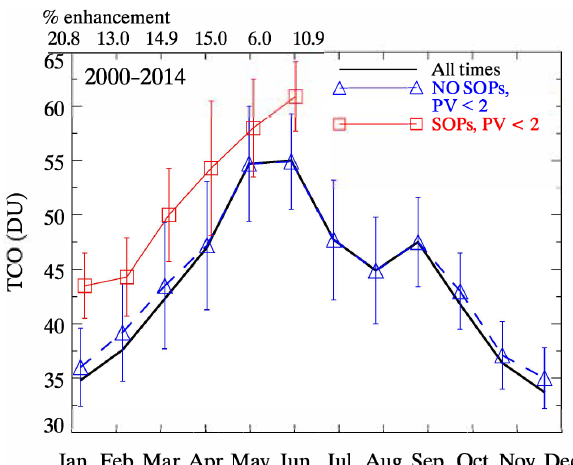
Figure 12. Annual cycle of EMAC-simulated TCO over the cen- tral Himalayas calculated from (1) all EMAC time steps (all times), (2) only the time steps having SOPs (SOPs), and (3) only when SOPs are not present (non-SOPs) over the period 2000–2014. En- hancements in TCO values (in %) during SOPs compared to non- SOPs are also indicated. TCO values for SOPs and non-SOPs are derived only when the average PV value at 10–12km is up to 2PVU. Error bars represent the standard deviation derived from the temporal variations over the period of